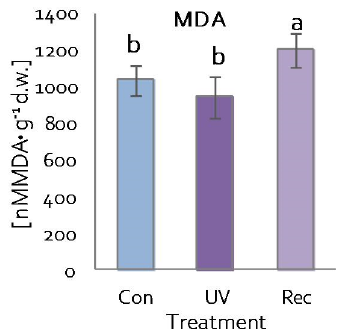
Figure 6. Malondialdehyde (MDA) content in D. muscipula leaves under UV-A treatment; Con—control plants; UV—UV plants; Rec—recovery plants; different letters—statistically significant differences at p ≤ 0.05; n = 5.